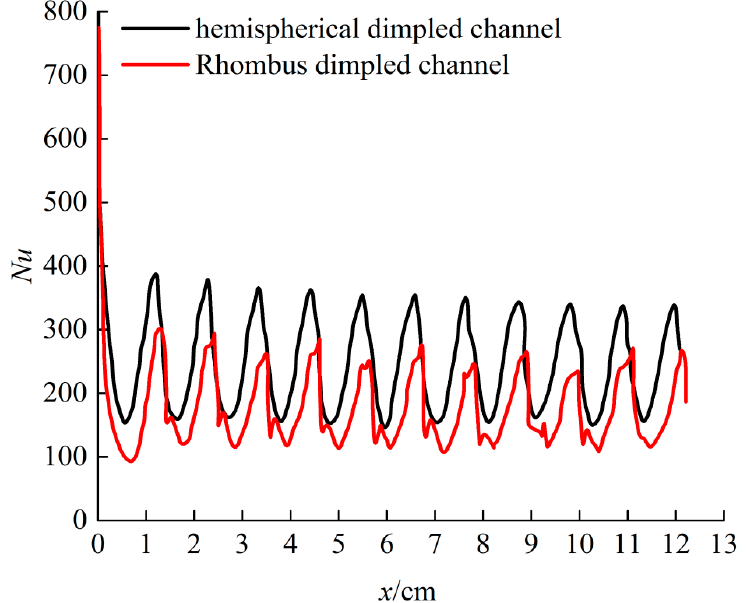
Figure 13. The CFD results of Nusselt number along the flow direction of different dimpled chan- nels.